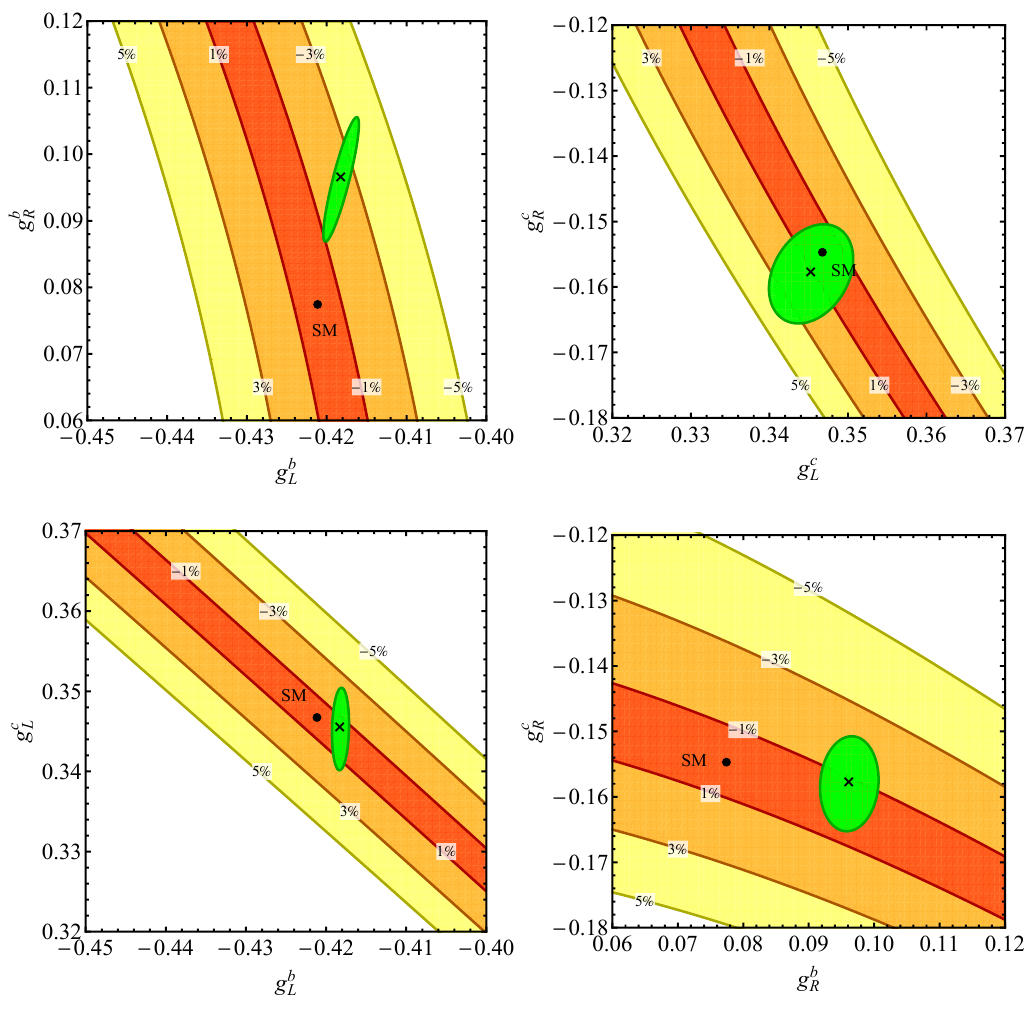
b { g b (upper left), g c { g c (upper right), g b { b=c in the g L R L R L